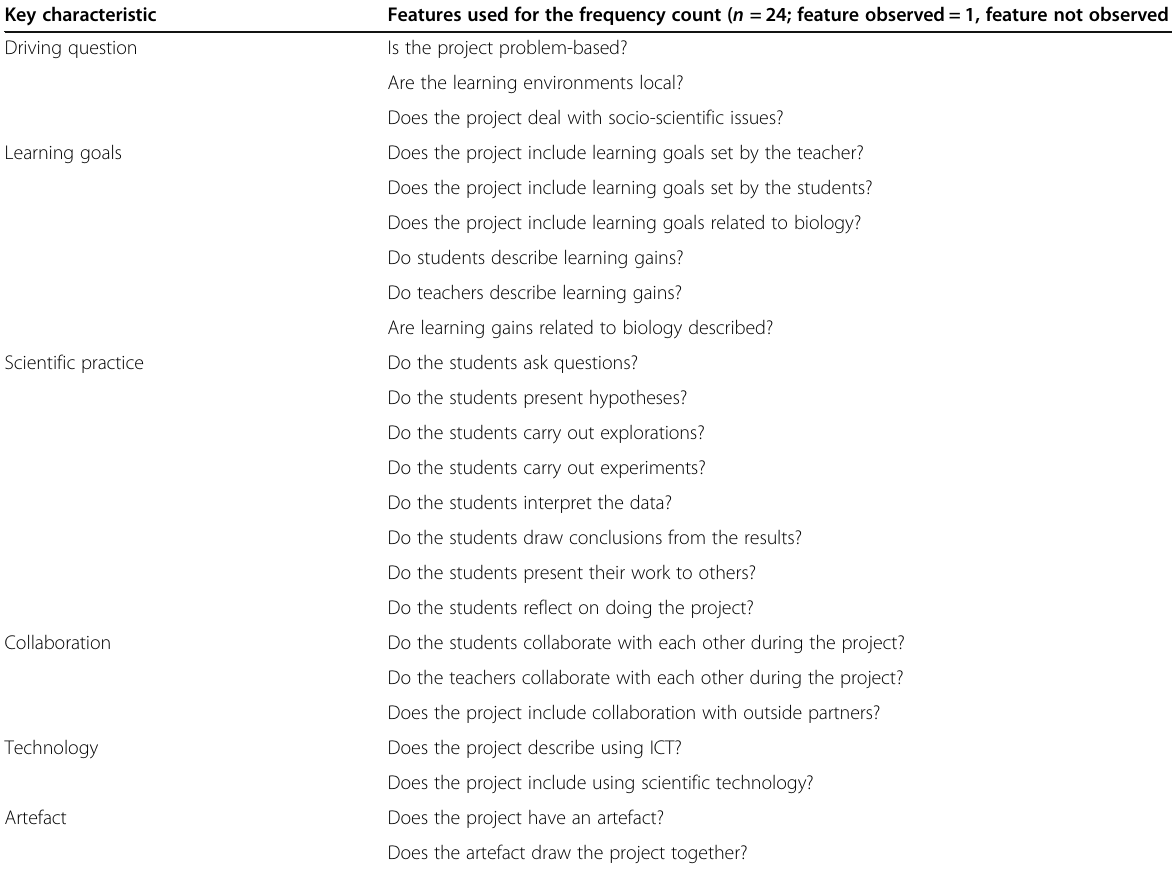
Table 4 Features used to study the distribution of the frequencies of PBL characteristics Key characteristic